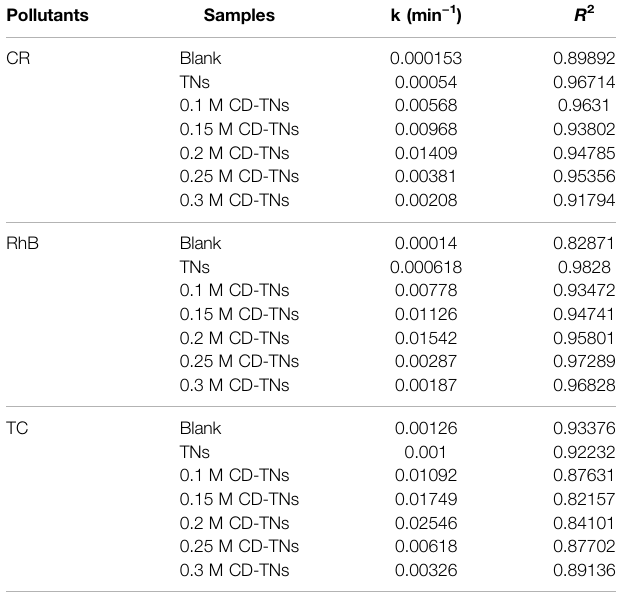
TABLE 1| Degradation kineticparametersofCR, RhB, and TC over TNsand CD- TN photocatalysts.